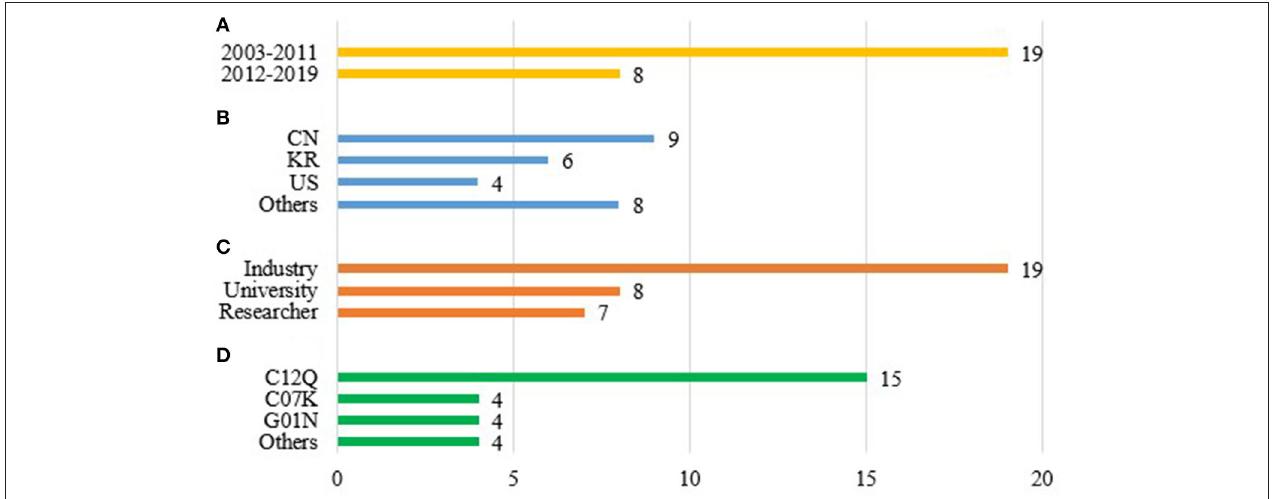
FIGURE 2 | Final selection of patents. (A) Publication date. (B) Country of patent publication. CN, China; KR, Republic of Korea; US, United States of America. Others: CA, Canada; DE, Germany; JP, Japan; NL, Netherlands; SG, Singapore; WO, World Intellectual Property Organization. (C) Patent applicant. (D) International